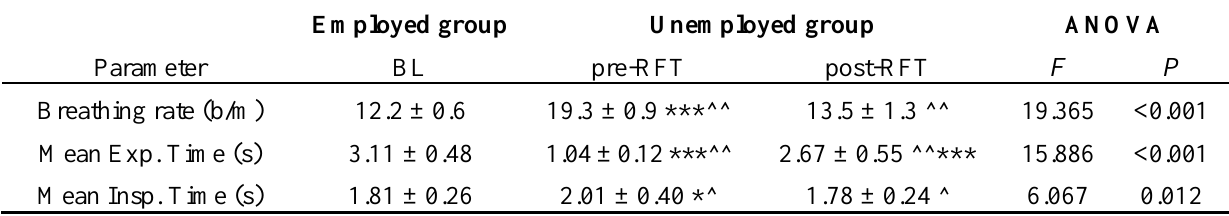
Table 4. Summary of the respiration